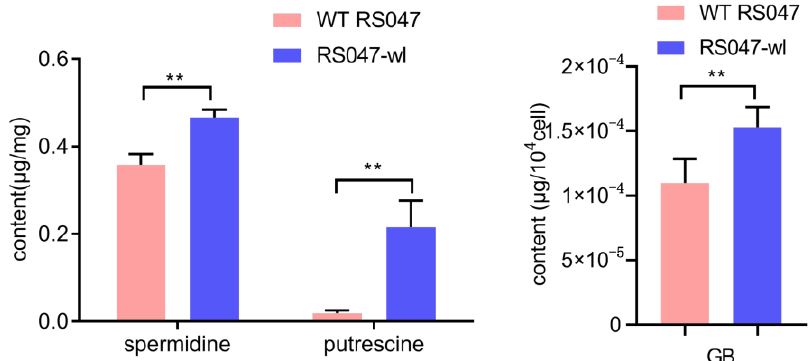
Figure 11. The content of spermidine, putrescine, and GB in WT RS047 and RS047-wl. Data represent mean ± SEM of at least three independent experiments. ** p < 0.01.